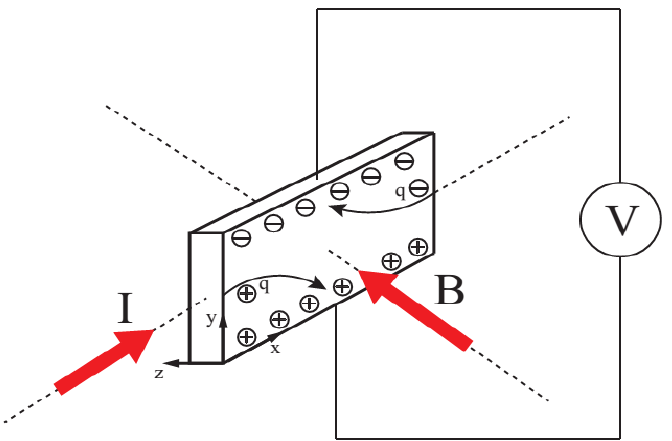
Figure 11. Schematic of the Hall